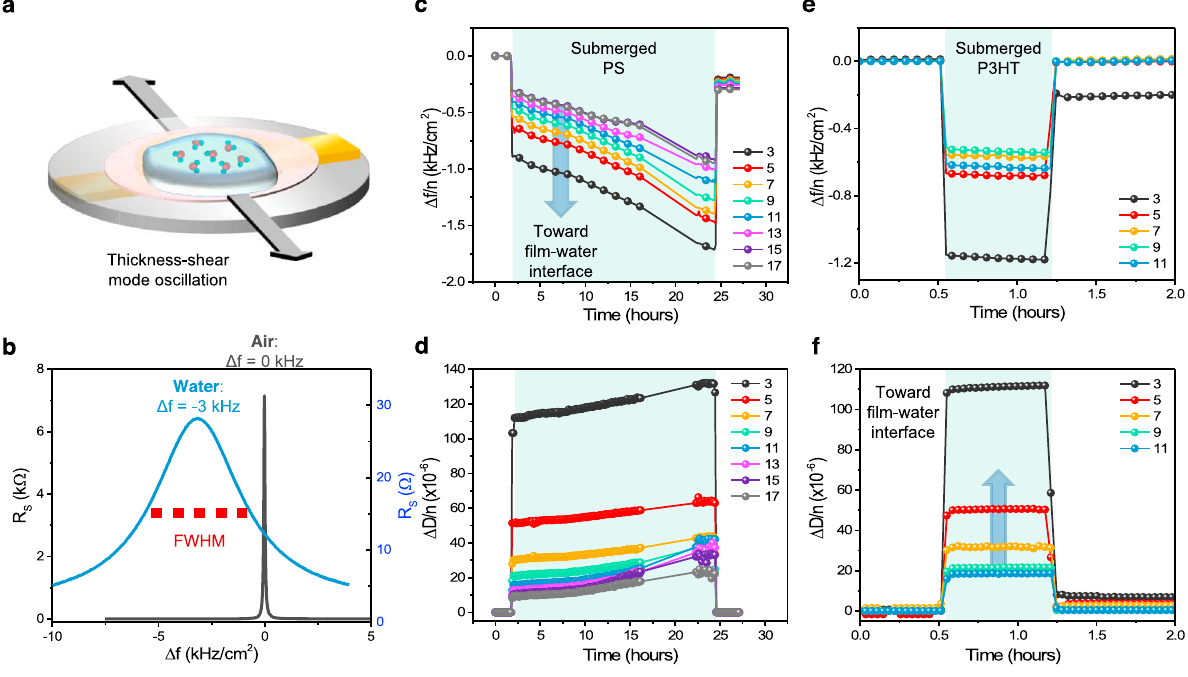
Fig. 4 Quartz crystal microbalance analysis of PS and P3HT fi lms submerged in DI water. a Illustration of fi lm (pink) on the quartz sensor submerged in water. b Representative response of QCM coated with P3HT during transfer from air to water. FWHM corresponds to full width at half the maximum intensity. c , d Normalized frequency shift and change in energy dissipation of ~100 nm PS submerged in water for 20 + h. e , f Normalized frequency shift and change in energy dissipation of ~100 nm P3HT submerged in water for ~40